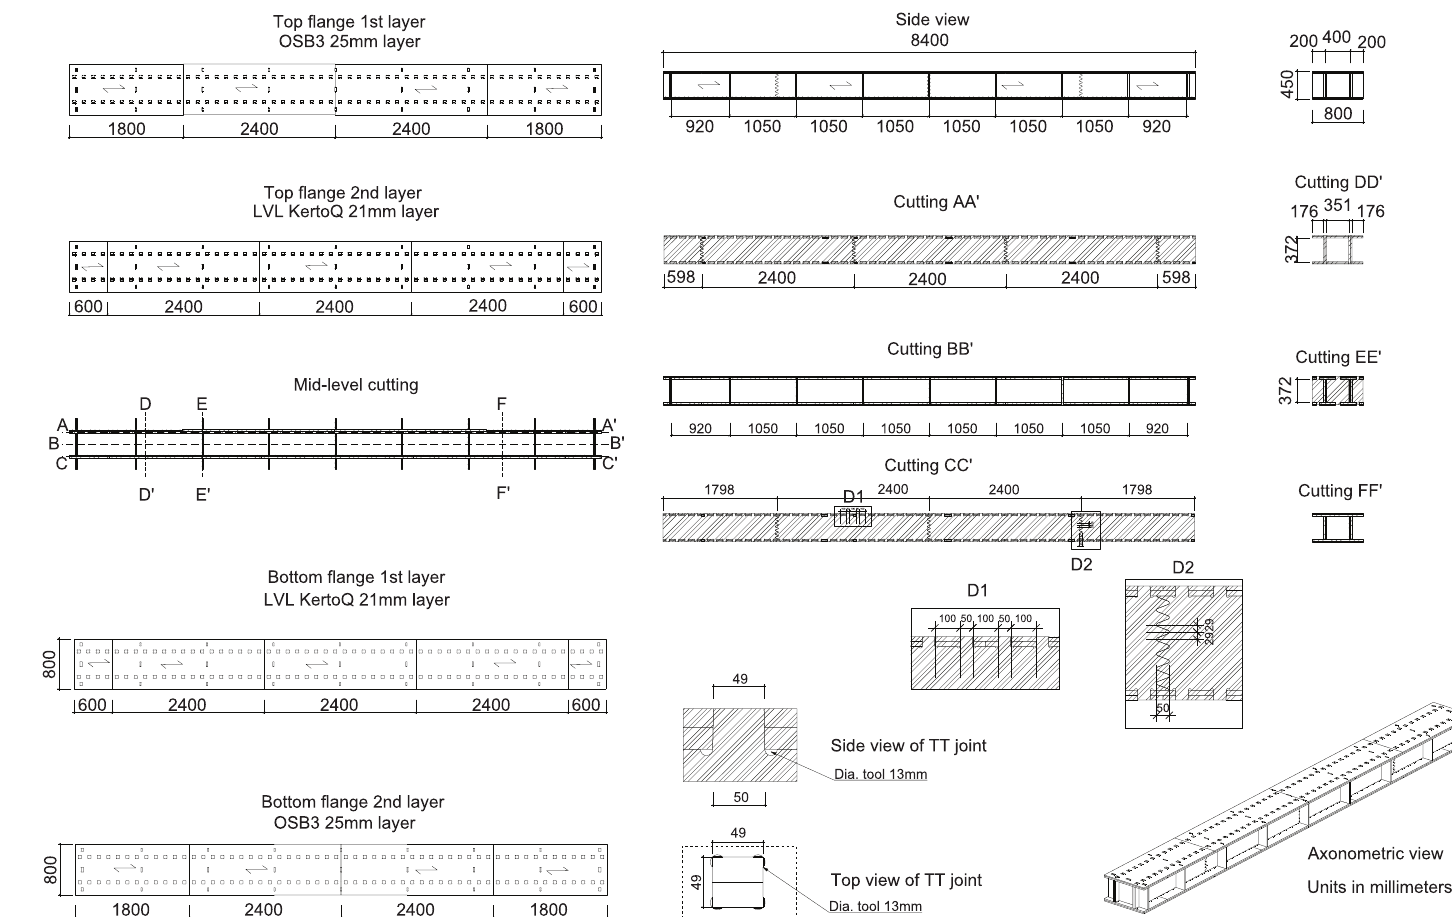
Figure A1. Detailed plan of large-scale